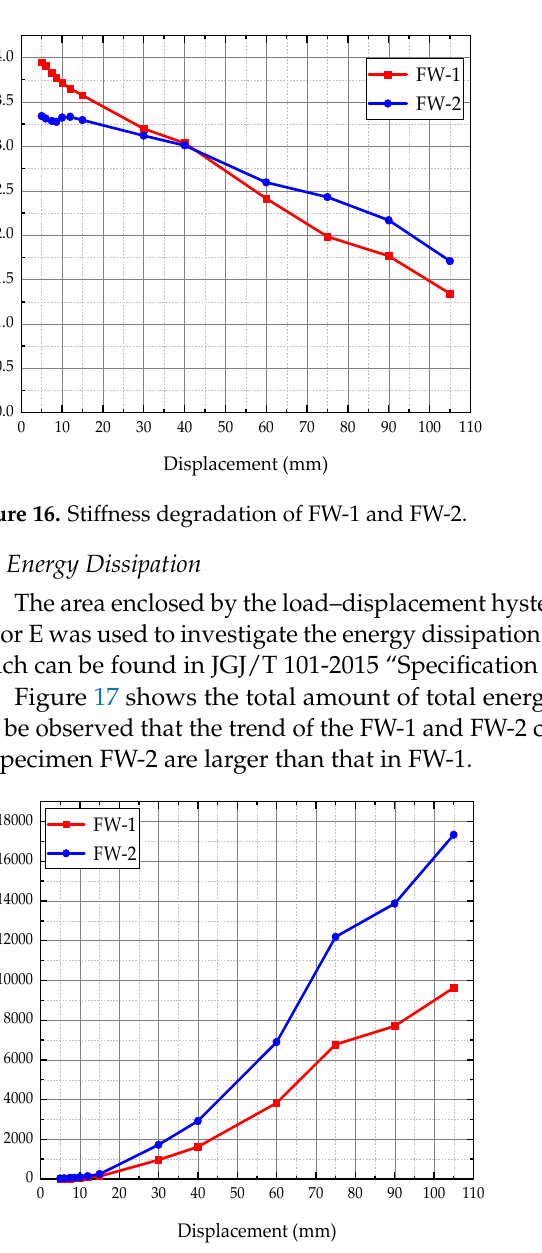
Figure 17. Energy dissipation of FW-1 and FW-2.